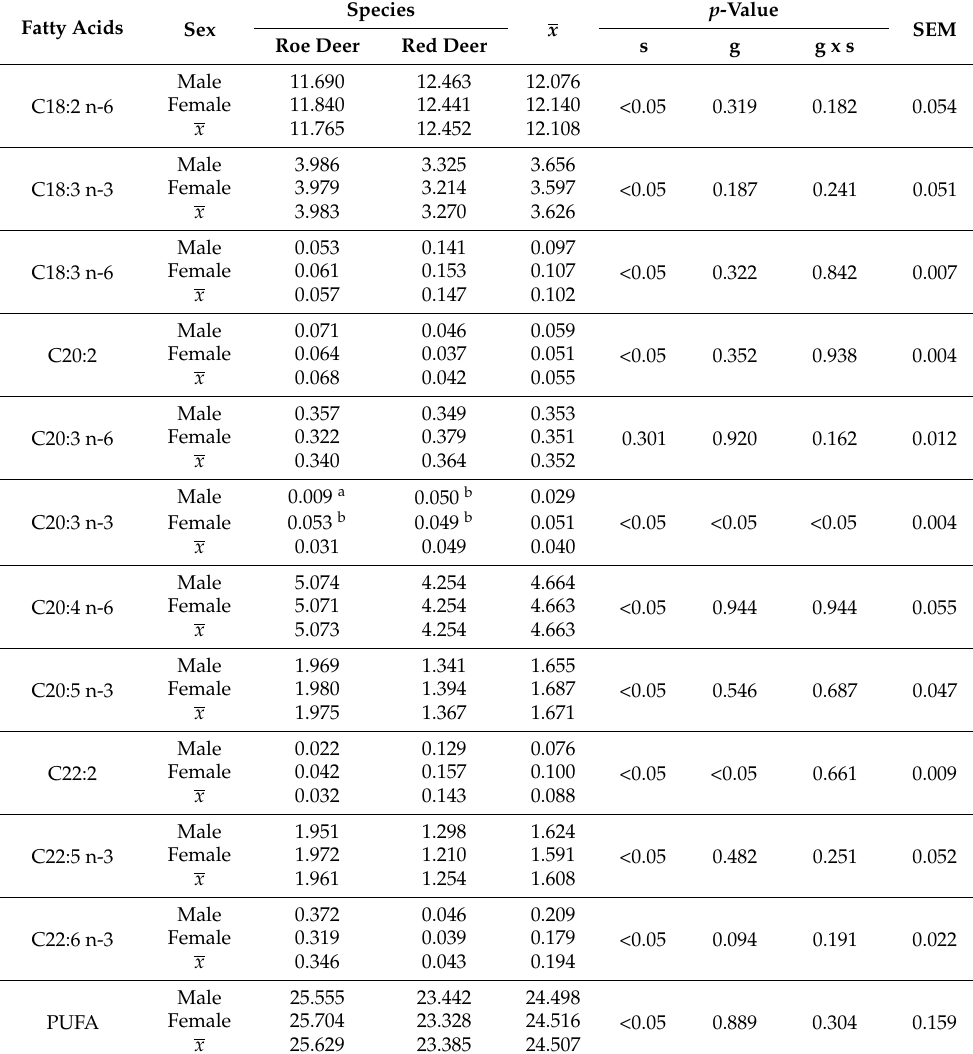
Table 5. Polyunsaturated fatty acids profile (% total) of